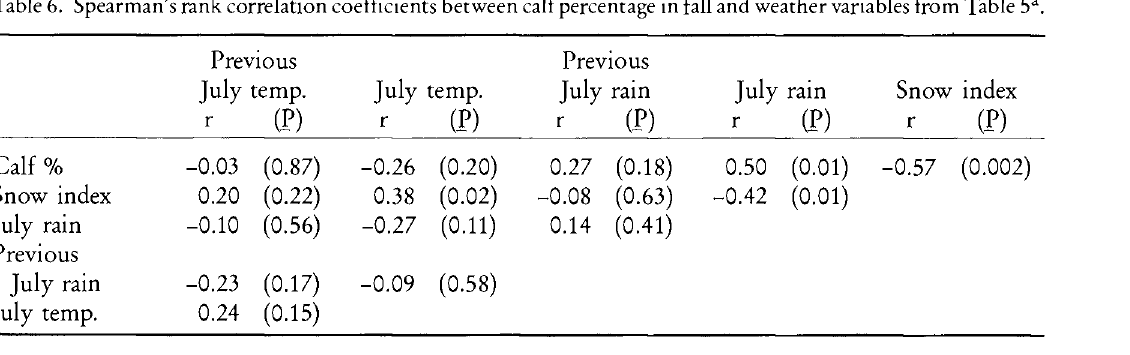
Table 6. Spearman's rank correlation coefficients between calf percentage in fall and weather variables from Table 5 a